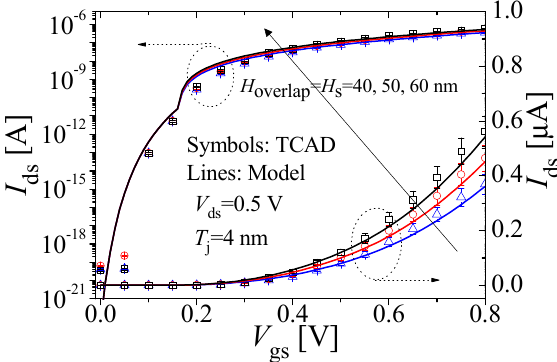
Figure 8. I ds – V gs characteristics of LTFET with T j = 4 nm, H overlap varied, and V ds = 0.5 V. Blue, red, and black represent H overlap = H s = 40, 50, and 60 nm, respectively. Symbols and lines denote TCAD simulation and model results, respectively. Error bar: 10%.